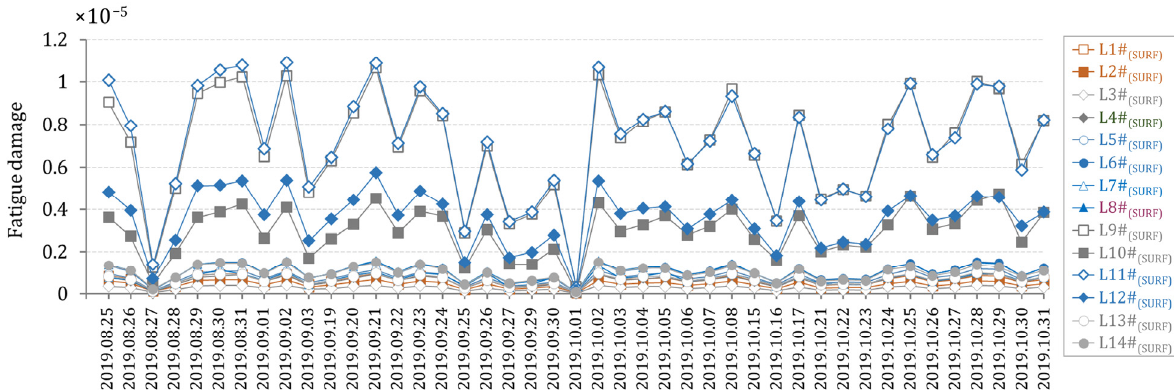
Figure 17. Fatigue damage during the test period.